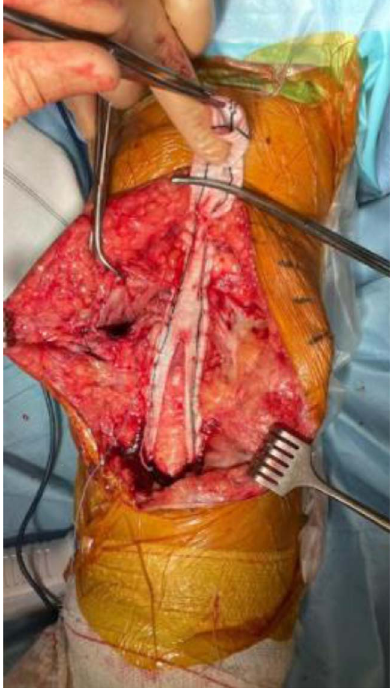
Figure 15. Suturing the graft along the extensor